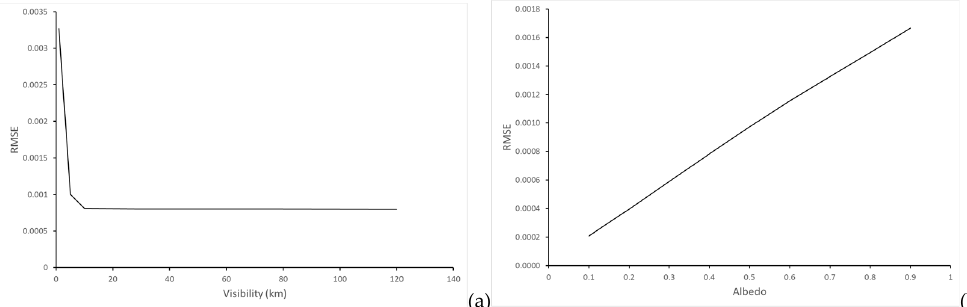
Figure 5. RMSE dependence on the visibility for an albedo of 0.4 ( a ), and on the albedo for a visibility of 30 km ( b ).